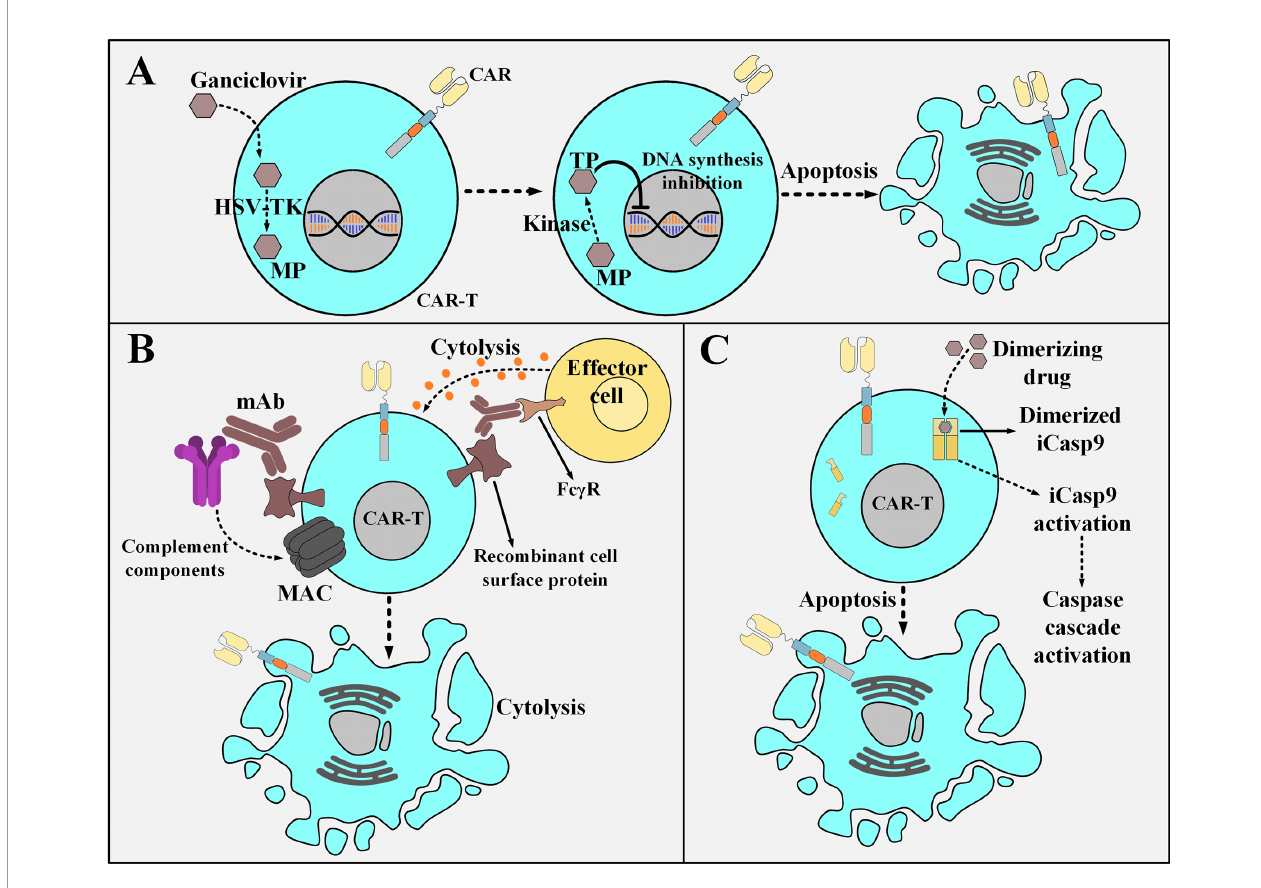
FIGURE 6 | Various strategies for the post-infusion controlling of CAR T cells. (A) The HSV-TK safety switch and its mechanism of action. Upon the administration of ganciclovir, it is catalyzed to MP by HSV-TK. MP will eventually be phosphorylated to TP. Subsequently, TP disrupts DNA synthesis leading to the selective ablation of CAR T cells. (B) An example a mAb-based safety switch and its mechanism of action. Co-expression of a desired recombinant cell surface protein enables selective elimination of CAR T cells expressing that molecule through the administration of pharmaceutical-grade mAbs which are speci fi c for it. This elimination is mediated by the engagement of immune effector cells or complement fi xation. (C) The iCasp9 suicide switch and its mechanism of action. The administration of the dimerizing drug results in the dimerization of the iCasp molecule. The dimerized iCasp is now activated and can trigger downstream apoptotic cascades that result in the death of the CAR T cells harboring this switch. HSV-TK, Herpes simplex virus thymidine kinase; MP, ganciclovir-monophosphate; TP, ganciclovir-trisphosphate; MAC, membrane attack complex; mAb, monoclonal antibody; Fc g R, Fc g receptor; iCasp9, inducible caspase